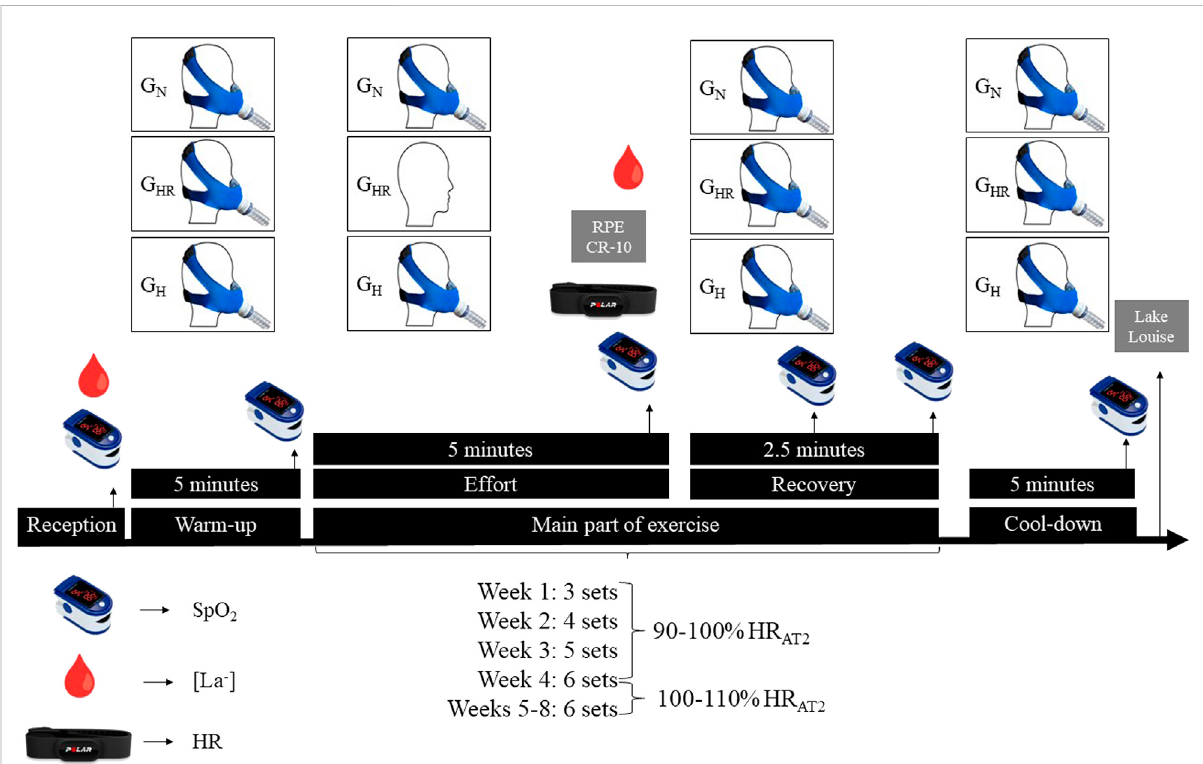
FIGURE 1 Experimental design of the training session. G N = group in normoxia; G HR = group in hypoxia recovery; G H = group in hypoxia; RPE = rate of perceived exertion;